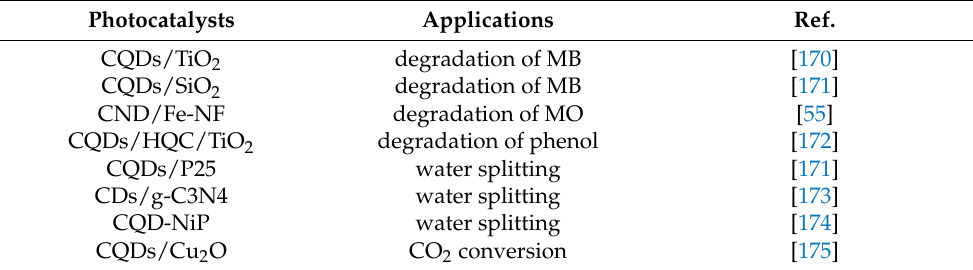
Table 3. CDs-derived photocatalysts in the different application